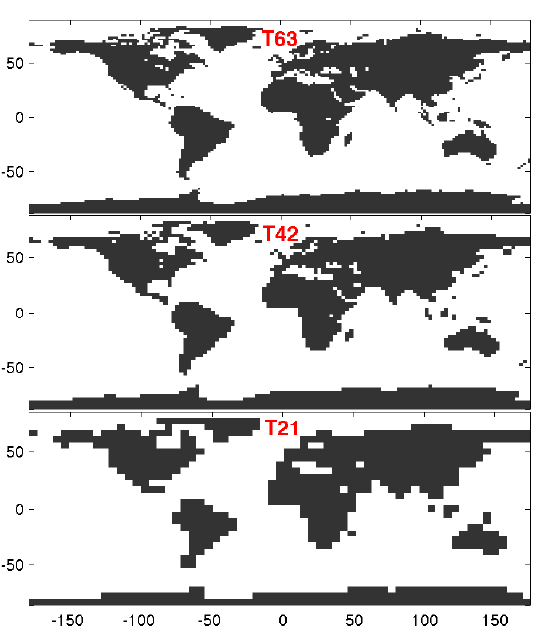
Fig. 1. Model coastline at horizontal resolutions used in this study: 209 km at Equator (T63), 313 km (T42) and 626 km (T21). Equator) with 19 vertical levels up to ca. 30 km). We wanted to test the influence of a coarse horizontal resolution on the Table 1. Details of model resolutions (horizontal and vertical) used horizontal diffusion of atmospheric particles. (2) An aver- age horizontal and high vertical resolution typically used for 10 Be studies (T42L31, ca. 313 km horizontally with 31 vertical levels up to ca. 30 km), (3) An average horizontal and coarse vertical one but including the whole stratosphere (T42L39, 313 km horizontally with 39 levels up to ca. 80 km. This vertical resolution is similar to L19 up to 30 km), (4) A fine horizontal and vertical resolution (T63L31, 209 km horizontally and 31 vertical levels up to ca. 30 km) and (5) A fine resolution, including the whole stratosphere (T63L47, 209 km horizontally with 47 vertical levels up to 80 km). Cor- respondingly, this resolution is comparable with the L31 at lower levels. T63L47 was pushing towards the limit of com- putational cost of our simulations prohibiting its use for long experiments. The model coastline, as described by the vari- ous horizontal resolutions, is shown in Fig. 1. A summary of the resolutions used is given in Table 1.